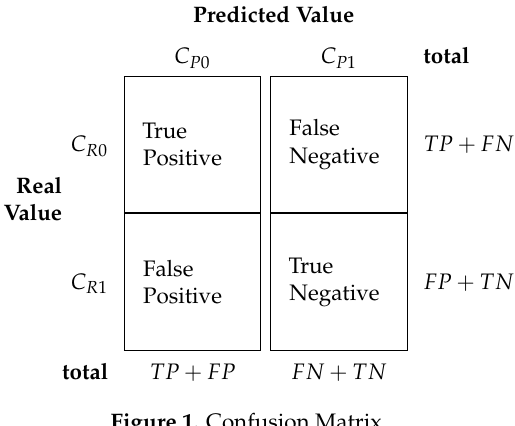
Figure 1. Confusion